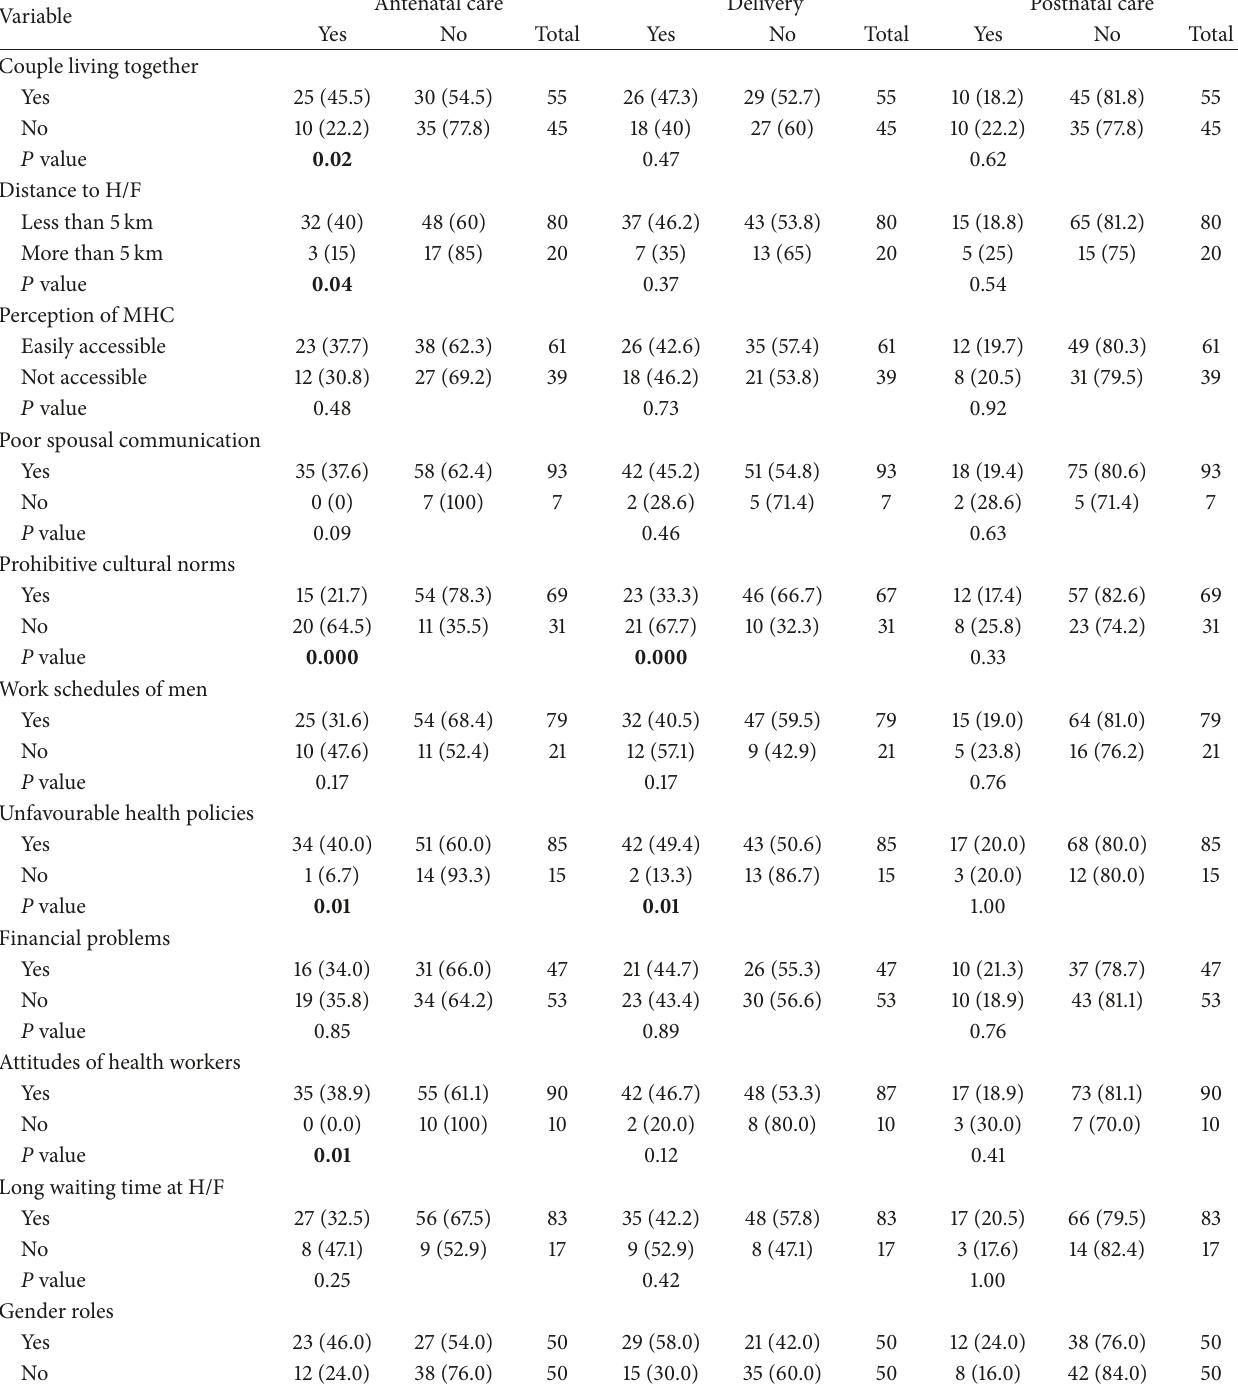
Table 4: Enabling/disenabling factors associated with male involvement in antenatal care, delivery, and postnatal care ( N = 100). Antenatal care Variable